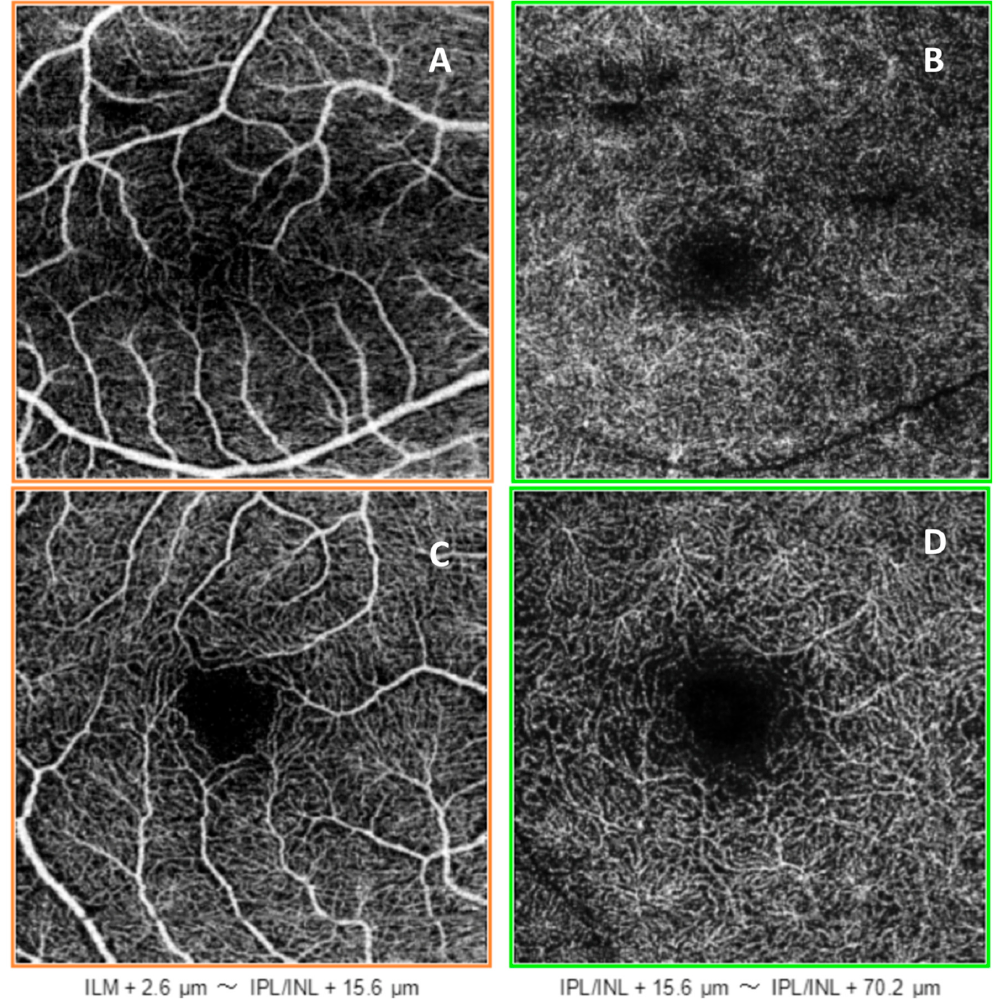
Figure 1. ( A , B ) Optical coherence tomography angiography (OCT-A) of 4.5 × 4.5 mm (DRI OCT Triton (plus), TOPCON Co., Japan) corresponding to the right eye of a patient with ROP that required laser treatment. In the superficial capillary plexus (SCP) segmentation ( A ), a decreased foveal avascular zone (FAZ) (43.97 µ m 2 ) and disorganization of the capillaries in the deep capillary plexus (DCP) ( B ) were observed. ( C , D ) OCT-A of 4.5 × 4.5 mm (DRI OCT Triton system, Topcon) corresponding to a